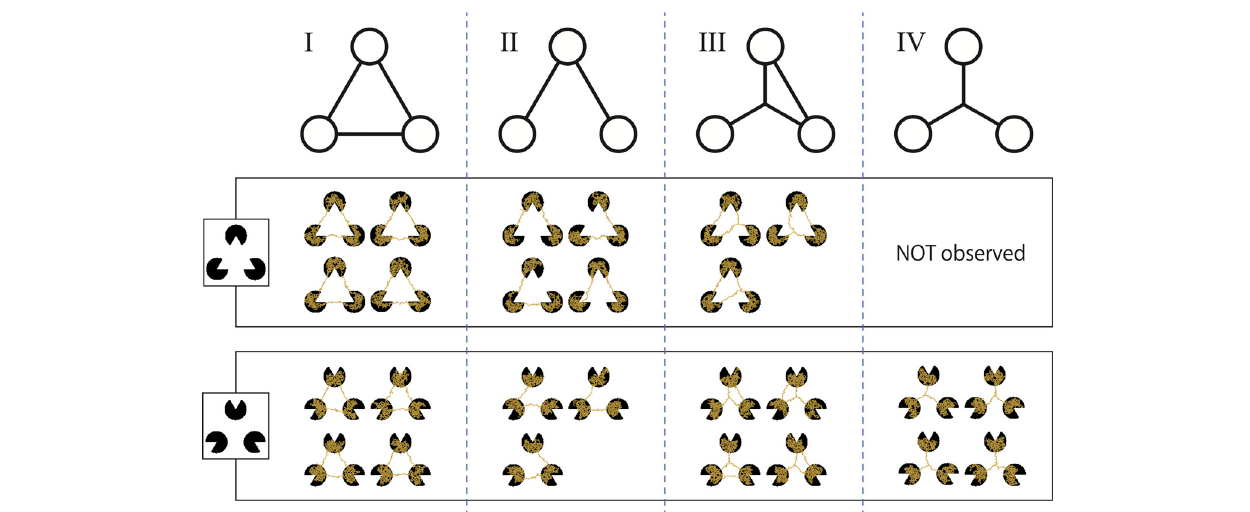
both conditions. To remove the effects of Kanizsa illusory contour, the pac-men are covered with black in the lower row. Obviously, the type I-like structure is apparent in the Kanizsa diagram case ( Figure 9A ), and the structure that is the sum of type I and type IV networks appears in the control ( Figure 9B ). This observation does not conflict with our model results because type I networks appeared dominantly in the Kanizsa diagram case, but in the control, type I and type IV networks were obtained in almost the same ratio. Next, we emphasize this difference numerically. We defined the target region of evaluation as depicted in Figure 10 . The yellow-colored marginal area of the fan that cen- ters a pac-man was divided into six regions. All of these fans had the same central angle of 15 ◦ and were labeled A to F accord- ing to the direction from the center. The same labeled areas were identified. For each region, the ratio of the area occupied by plasmodium was measured. We precisely counted the num- ber of black pixels, which indicated that the site was occupied by plasmodia in the binary converted images (see, for example, Figure 5D ). To normalize the values, the number of black pixels was divided by the total number of pixels for each region. The relationships between the mean values of the occupation ratios and directions are plotted in Figure 11